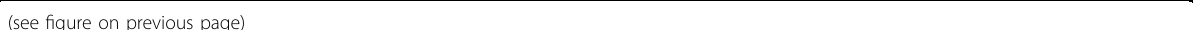
Fig. 2 Clinical ef fi cacy and safety of CD22-CAR FH80 T cell therapy. a Swimmer plot showing the clinical responses, response duration, and outcome in individual patients treated with CD22-CAR FH80 T cells. HSCT, hematopoietic stem cell transplantation. b Images showing the retreatment extramedullary disease detected by position emission tomography (PET), the reduction of intracranial mass detected by magnetic resonance imaging (MRI), and the reduction of chest wall mass detected by computed tomography (CT) during CAR T cell treatment in patient 6. The red dotted circle indicates the border of a leukemia mass. c Absolute number of CAR T cells (above panel) and the percentage of CAR T cells among CD3 + T cells (below panel) in the peripheral blood of eight patients who received CD22-CAR FH80 T cell therapy. d Representative dot plot, detected by fl ow cytometry, showing the presence of CD22-CAR FH80 T cells among CD3 + T cells in the peripheral blood of two patients, including Pt 4 who achieved complete remission and Pt 5 who did not respond to the therapy. e Swimmer plot showing the duration of B cell aplasia in the bone marrow and hypogammaglobulinemia in four patients who achieved complete remission but received no further treatments. Serum immunoglobulins and bone marrow non-malignant B cells were determined by immunoturbidimetry and fl ow cytometry, respectively. f Swimmer plot showing the grade, duration, and management CRS and ICANS in each patient. The color in the swimmer lane indicates the existence of a speci fi c grade of CRS or ICANS at a speci fi c time point during CAR T cell treatment. IT intrathecal injection IV intravenous injection CRS Cytokine-release syndrome ICANS immune effector cell-associated neurotoxicity syndrome. g Symptoms of CRS and ICANS in individual patients during CD22-CAR FH80 T cell therapy. Horizontal lines indicate mean values of the grade of speci fi c